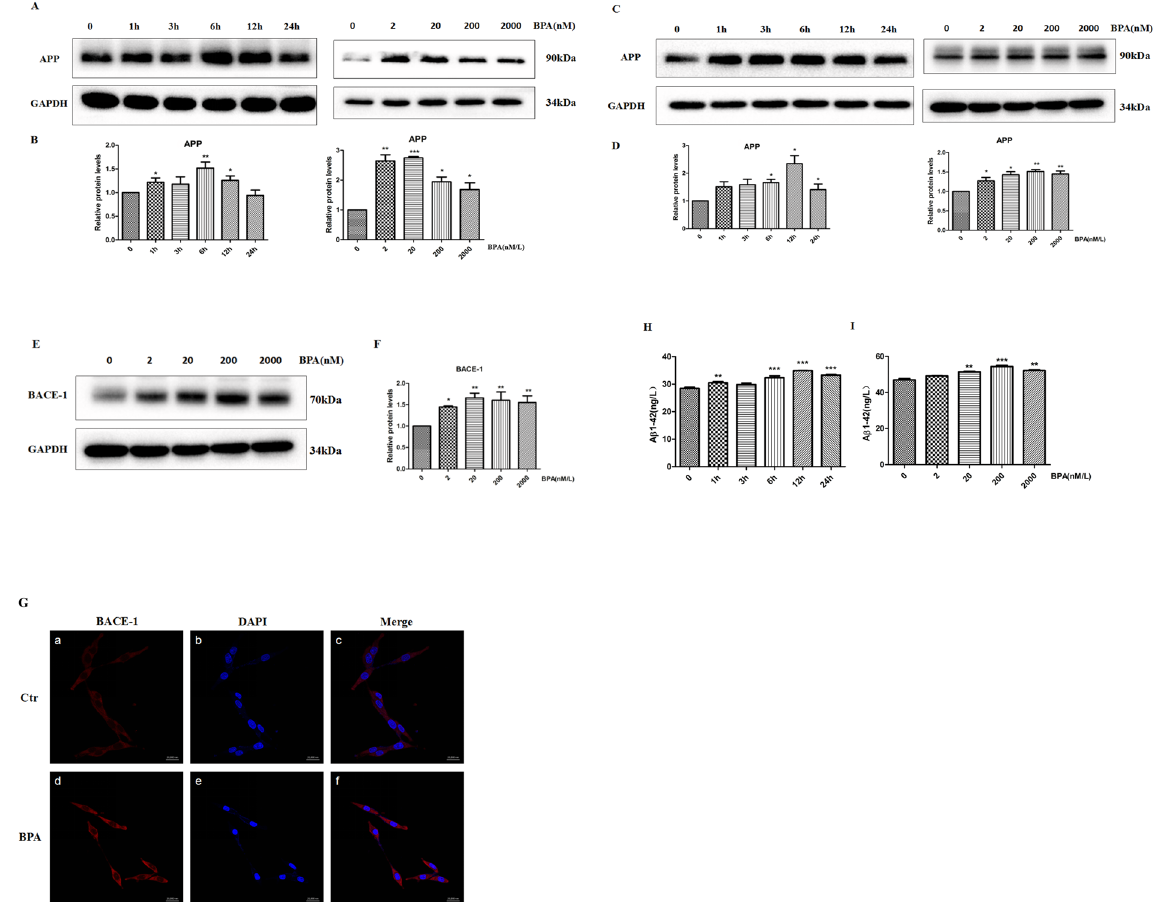
Figure 2. BPA upregulated APP, BACE-1 and A β 1–42 expressions. Western blot analysis of the expression of ( A ) APP protein in SY5Y cells treated with different concentrations of BPA (0, 2, 20, 200, and 2000 nM/L) at various time points (0, 1, 3, 6, 12 and 24 h). ( C ) APP and BACE-1 protein expressions in PC-12 cells at different concentrations of BPA (0, 2, 20, 200, and 2000 nM/L) at various time points (0, 1, 3, 6, 12 and 24 h). ( B , D , F ) GAPDH levels were assessed in parallel and served as controls. Data are presented as the mean ± SEM from three independent experiments. ( E ) Effect of different concentrations of BPA (0, 2, 20, 200, and 2000 nM/L) on BACE-1 expression in PC-12 cells. ( G ) Immunofluorescence analysis of the expression of BACE-1 protein after treatment with 20 nM/L BPA. ( H , I ) Effects of different concentrations of BPA on A β 1–42 expression in PC-12 cells determined via ELISA. Mean values ± SEMs are representative of three independent isolations and three independent samples. Significant differences between the treatment groups and the control group were determined via one-way ANOVA and the Dunnett multiple comparison procedure. ( * P < 0.05, ** P < 0.01, *** P < 0.001 compared with the control